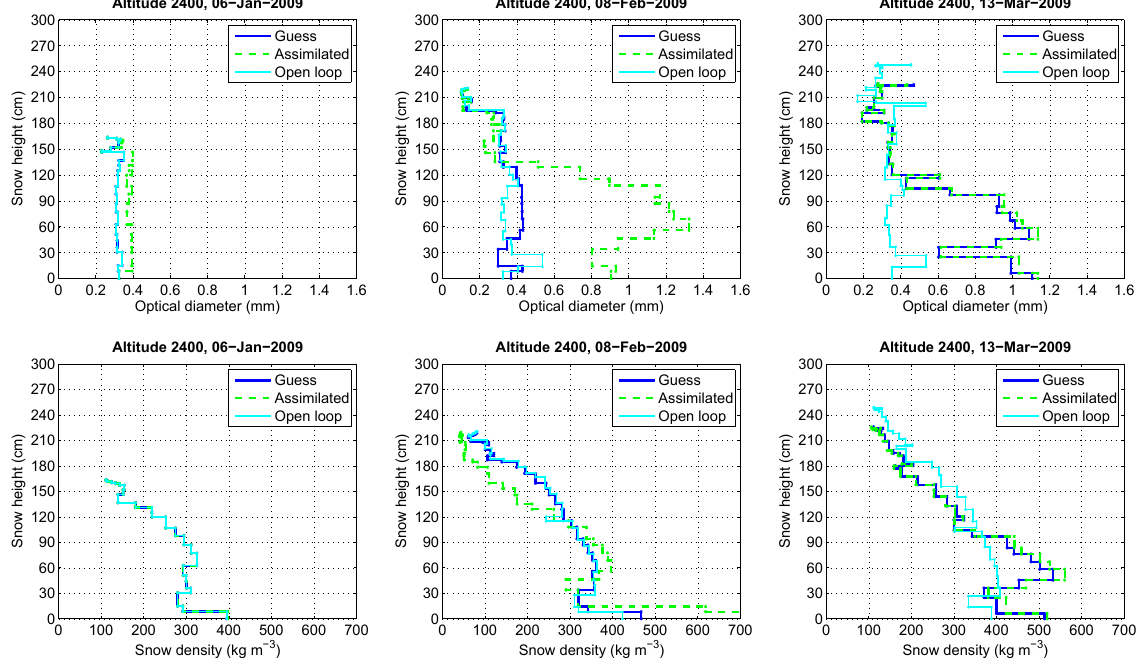
Figure 10. Results of 1D-Var data assimilation from some Crocus profiles, showing changes made by the data assimilation algorithm on optical diameter (top panels) and snow density (bottom panels) on 6 January (left panels), 8 February (middle panels) and 13 March (right panels). Note that the assimilation only affects directly the optical diameter and snow density. These direct modifications are injected into Crocus and propagate through the subsequent simulations, and may then lead to open-loop and assimilated profiles with different snow